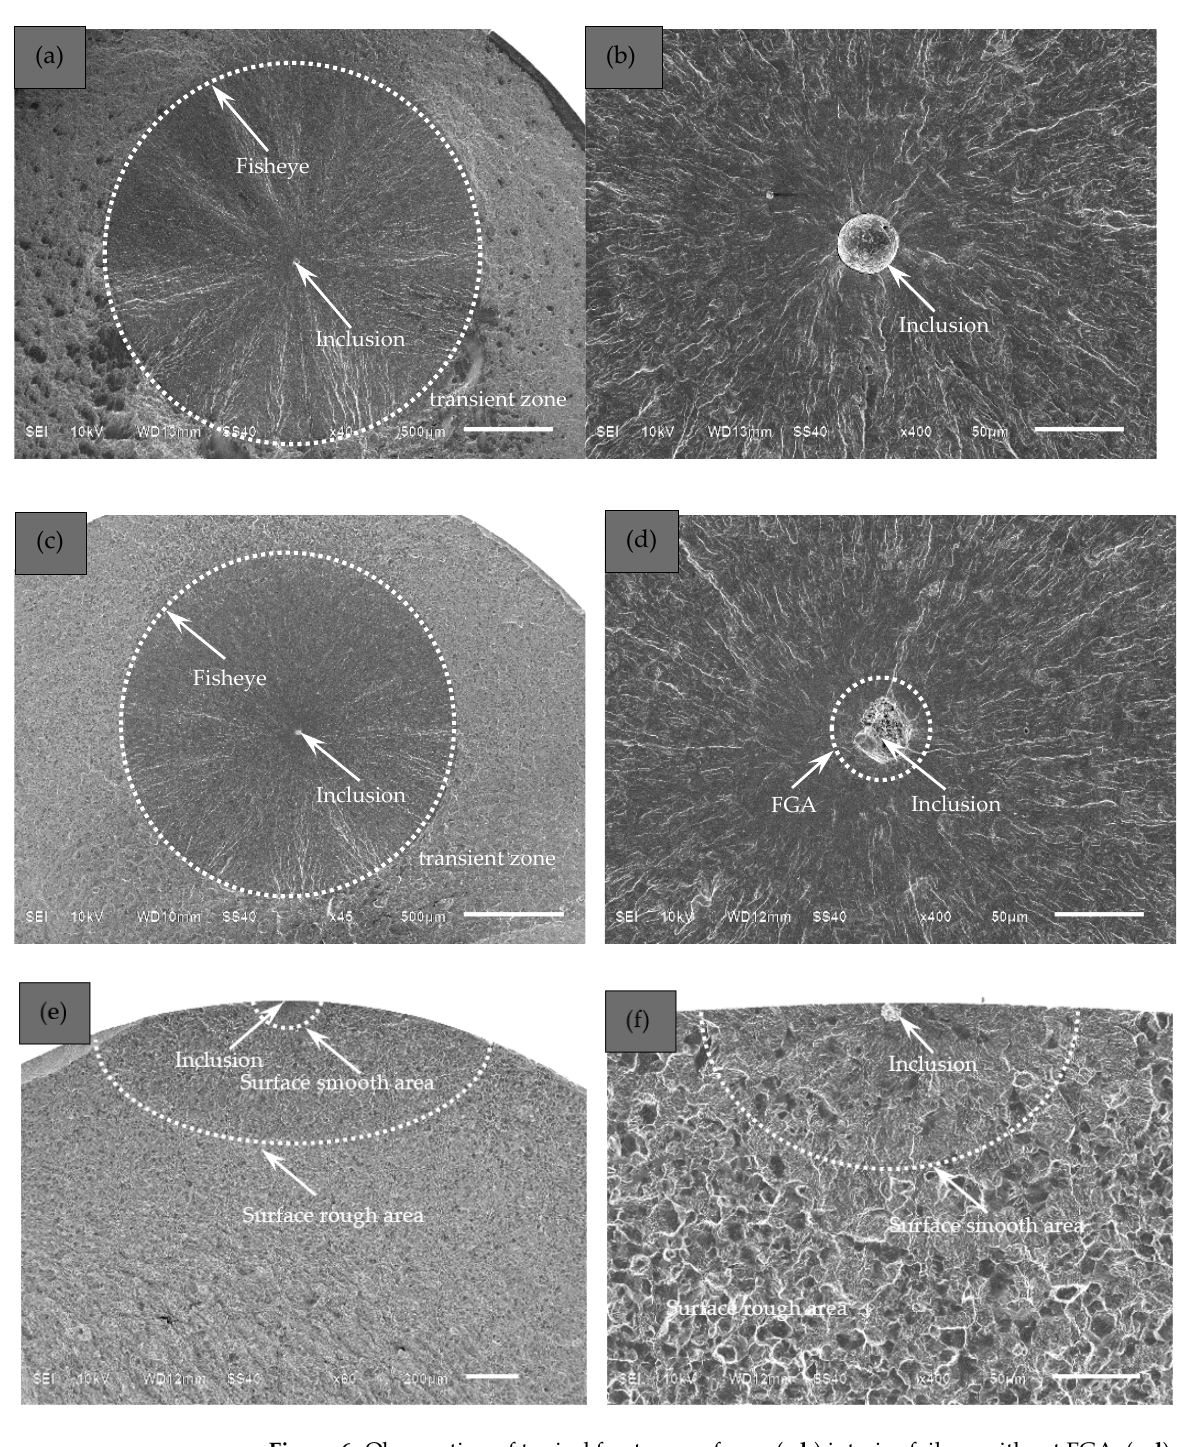
Figure 6. Observation of typical fracture surfaces: ( a , b ) interior failure without FGA, ( c , d ) interior failure with FGA and ( e , f ) surface failure. ( a ) Fisheye ( σ a = 800 MPa, N f = 370,800 cycles, R = − 1). ( b ) Inclusion without FGA ( σ a = 800 MPa, N f = 370,800 cycles, R = − 1). (c) Fisheye ( σ a = 700 MPa, N f = 4,768,700 cycles, R = − 1). ( d ) Inclusion with FGA ( σ a = 700 MPa, N f = 4,768,700 cycles, R = − 1). ( e ) Surface-induced failure ( σ a = 650 MPa, N f = 82,100 cycles, R = 0). ( f ) Inclusion. ( σ a = 650 MPa, N f = 82,100 cycles, R = 0).